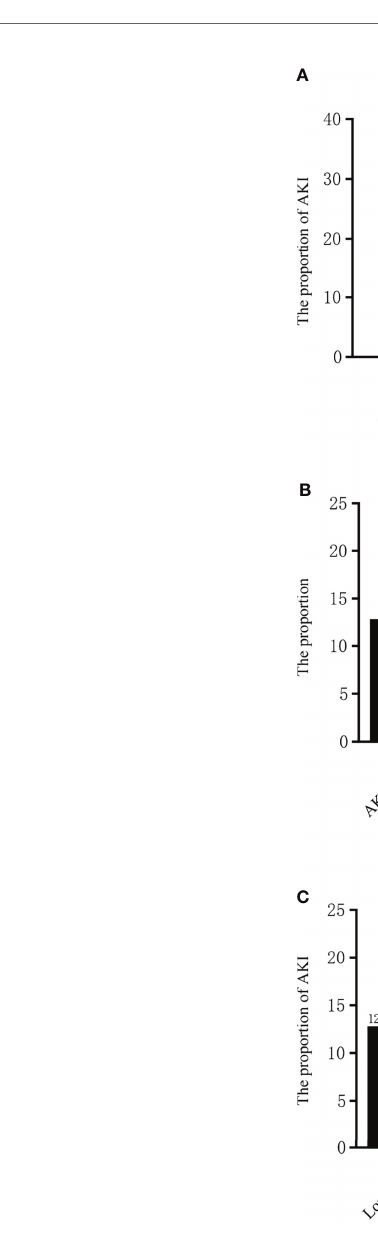
FIGURE 2 | (A) The incidence of sepsis-associated acute kidney injury (S-AKI) in each N/LP group were 29.1% (low N/LP group), 37.2% (middle N/LP group) and 36.9% (high N/LP group), respectively ( P =0.006); (B) the comparison in the proportion of each N/LP level in different AKI stages, the rates of stages 1, 2, 3 were 12.8%, 13.6, 2.7% in low N/LP group, and 15%, 17.8%, 4.4% in middle N/LP group, and 10.9%, 20.8%, 5.2%; (C) the proportion of each AKI stage in different N/ LP groups. AKI and corresponding stage are diagnosed based on serum creatinine and urine output criteria. Statistical analysis by Rank-Sum test; *, P <0.05; **, P